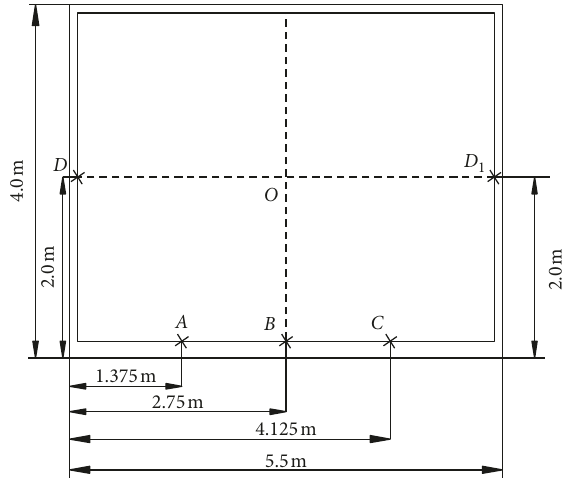
Figure 18: Monitoring point layout for the roadway